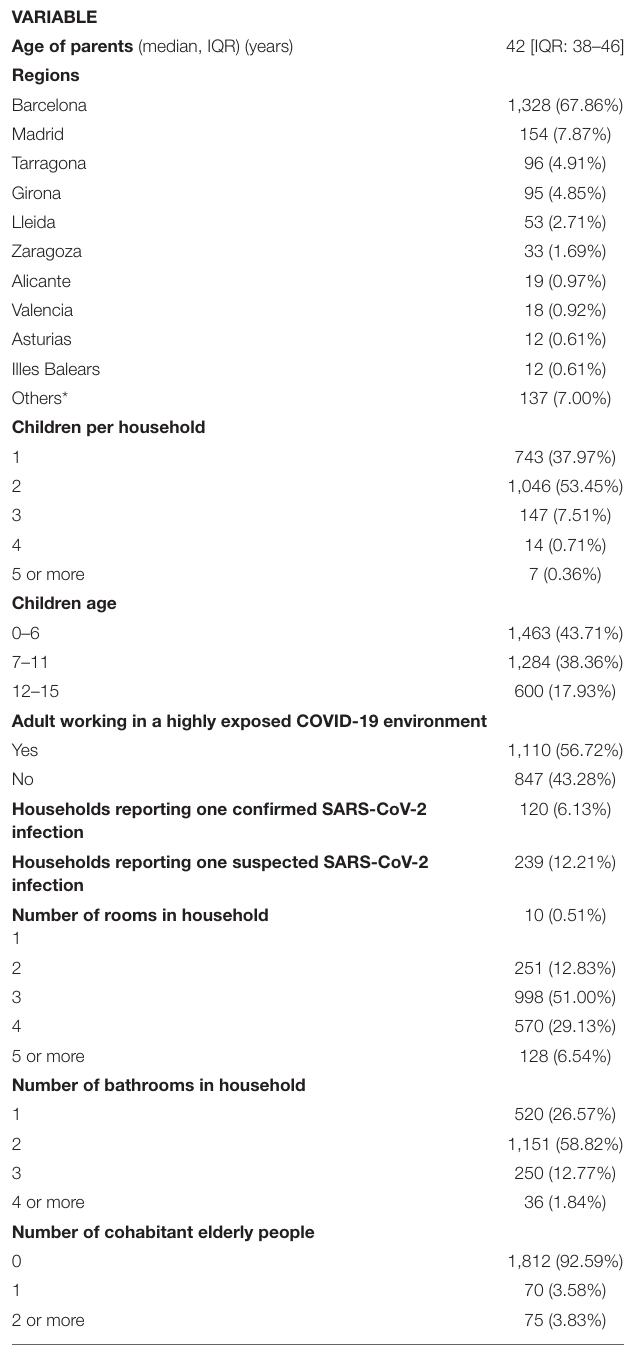
TABLE 1 | Characteristics of the 1,957 families included in the